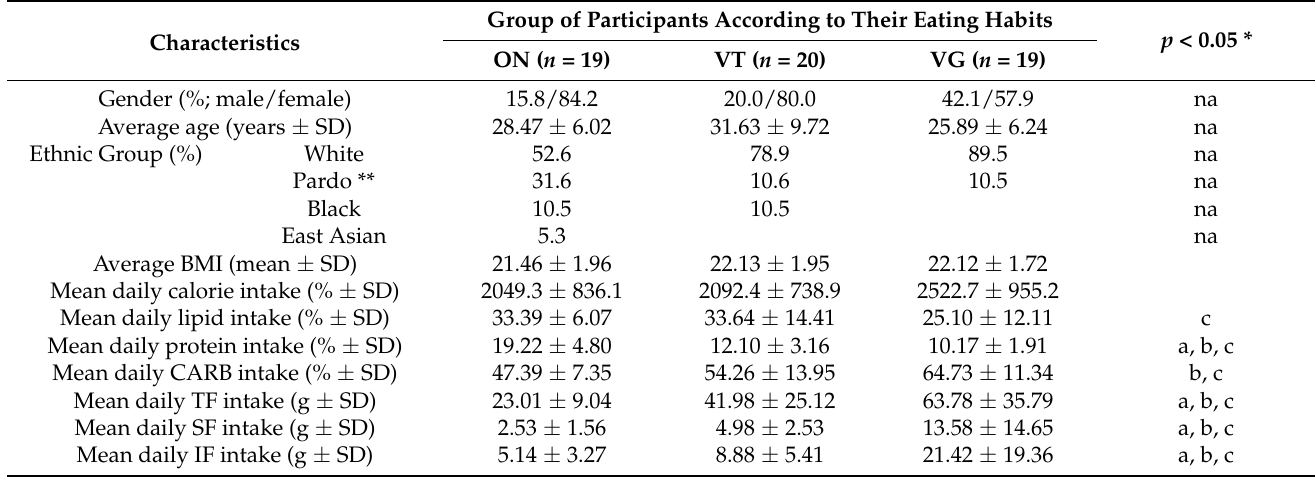
Table 1. Sociodemographic, anthropometric, and nutritional characteristics of the participants.